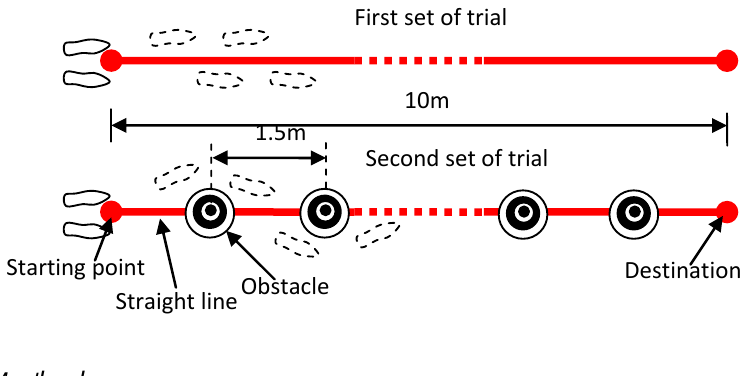
Figure 2. Two sets of trials designed in the experimental protocol. The distance between starting point and destination is 10 m for the two trial